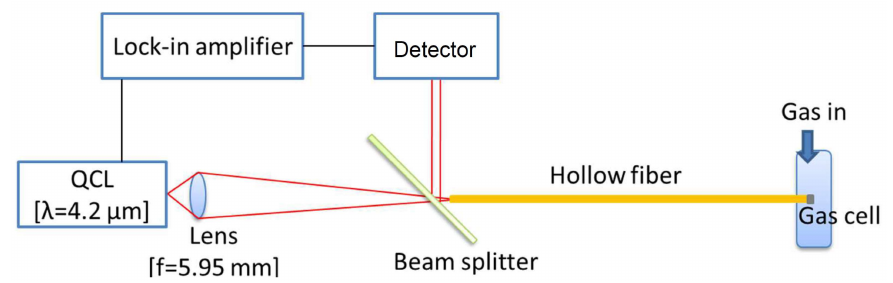
Figure 5. Schematic of the quantum cascade laser (QCL)-based CO 2 gas analysis system using a hollow optical fiber